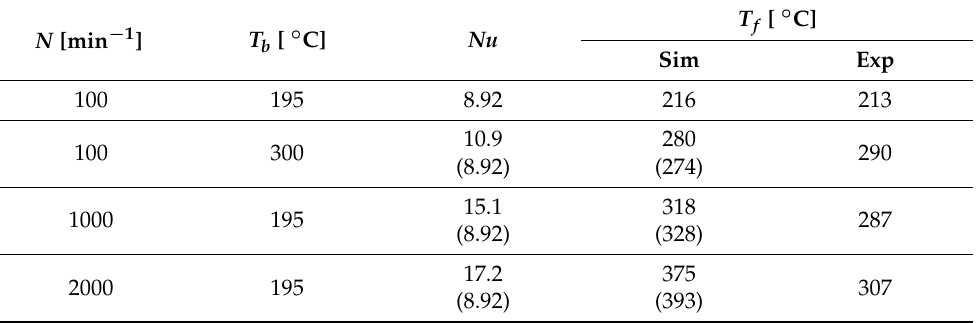
Table 2. Simulation and experimental results of the experiments described in Section 3.3. The outlet temperature is denoted by T f . The values of T f in parentheses were the calculated values at Nu =